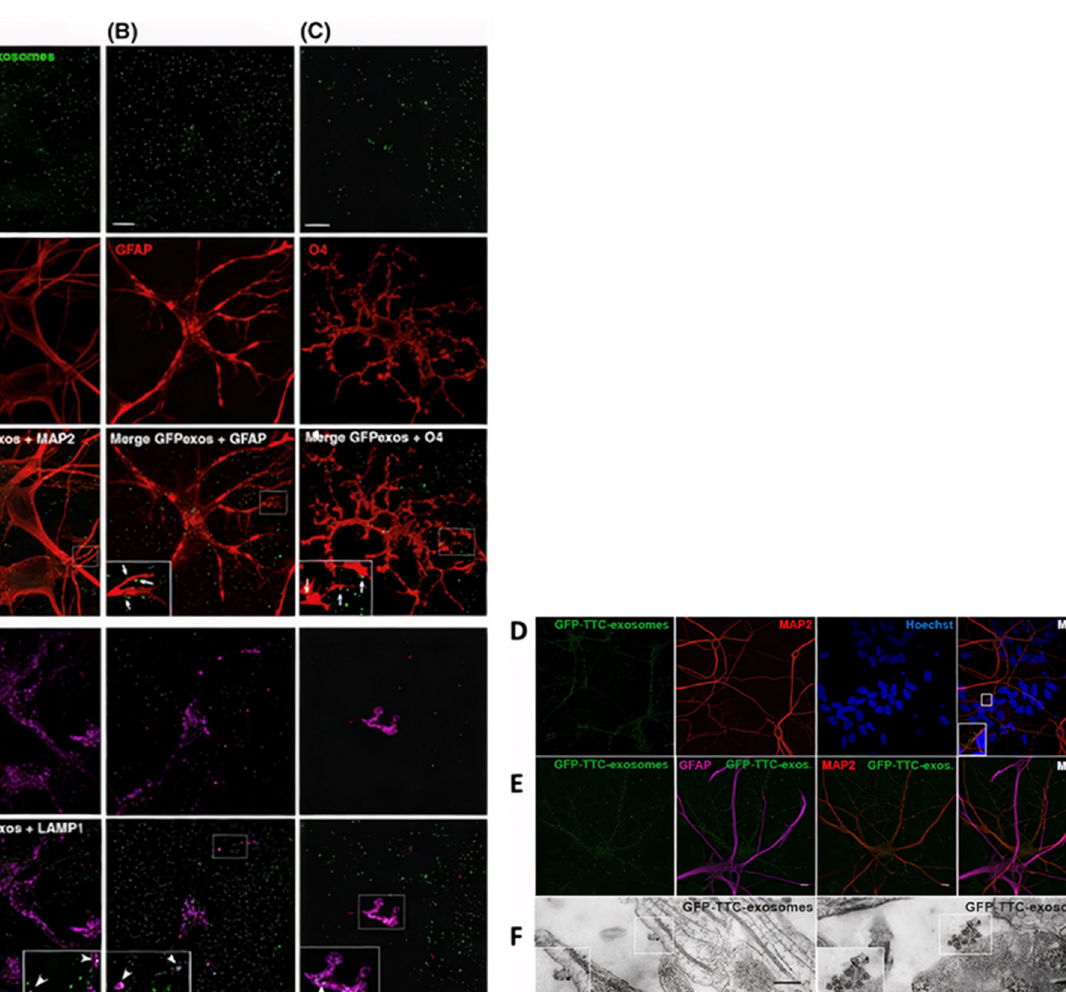
Figure 9. Impact of oligodendroglial exosomes on neuronal electrical activity. ( A ) Image of a 14 DIV pCN culture grown in a 9-channel MEA. Electrode spacing is 200 mm. ( B – E ) Recordings were performed at DIV 14. The blue vertical line indicates the application of pOL exosomes (red graph, n ¼ 9) or sham control (black graph, n ¼ 6) after 1 h of recording. Average channel number/well ( B ), relative spike firing rate ( C ), relative burst index ( D ), and relative spike amplitude ( E ) are depicted over 6 h of recording. Error bars+s.d. (* p , 0.05; Student’s t-test) [78]. Figure and caption reproduced with permission from Royal Society.